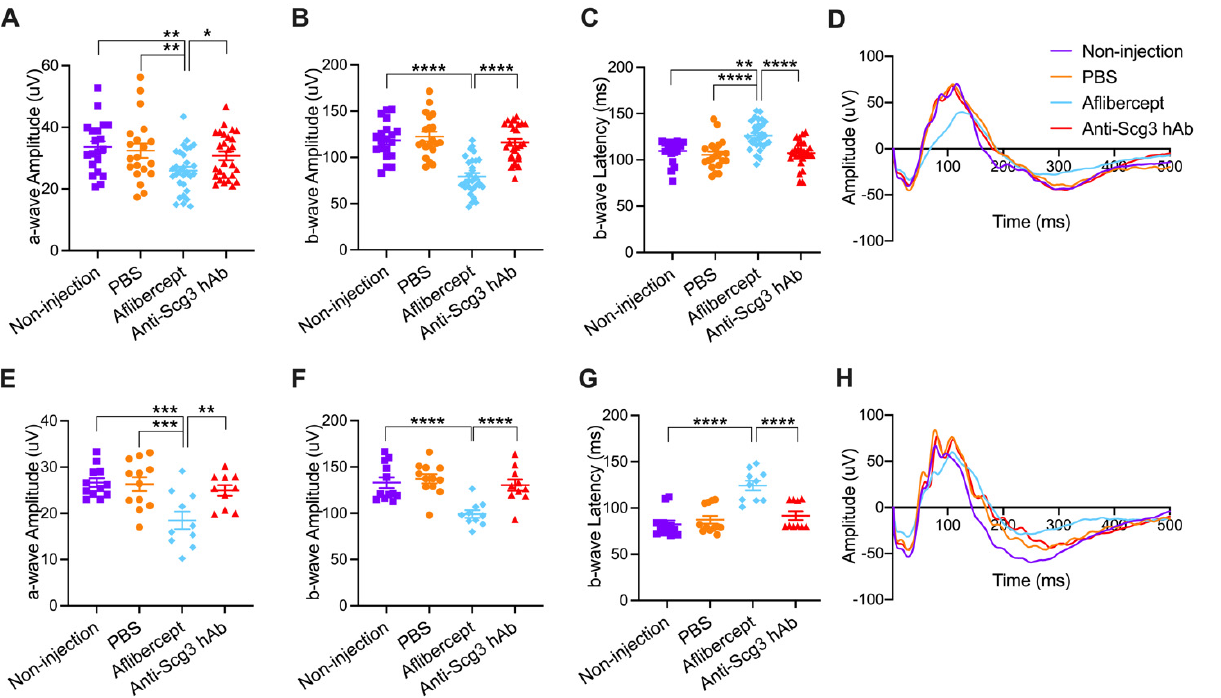
Figure 4. Intravitreal anti-Scg3 hAb does not adversely affect visual function in healthy neonatal mice. ( A – D ) Short-term pfERG of healthy mice at P21 (7 DPI). n = 20 eyes (non-injection), 20 (PBS), 27 eyes (anti-Scg3 hAb), and 30 (aflibercept). ( E – H ) Long-term pfERG of healthy mice at P42 (28 DPI). n = 12 eyes (non-injection), 12 (PBS), 10 (anti-Scg3 hAb), and 10 (aflibercept). ( A , E ), a-wave amplitude. ( B , F ), b-wave amplitude. ( C , G ), b-wave latency. ( D , H ), average ERG graphs of all mice in each group. Aflibercept decreased a- and b-wave amplitudes at P21 and P42 ( A , B , E , F ). Additionally,